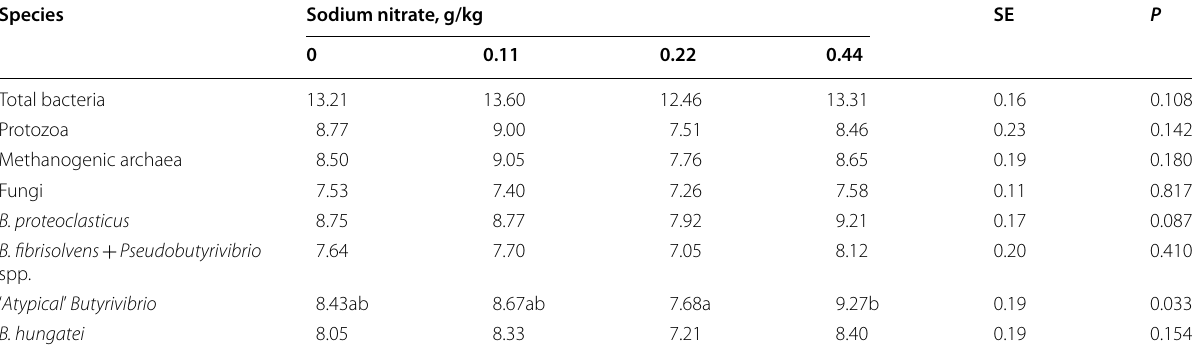
Different letters in the same row means significant differences ( P < 0.05)